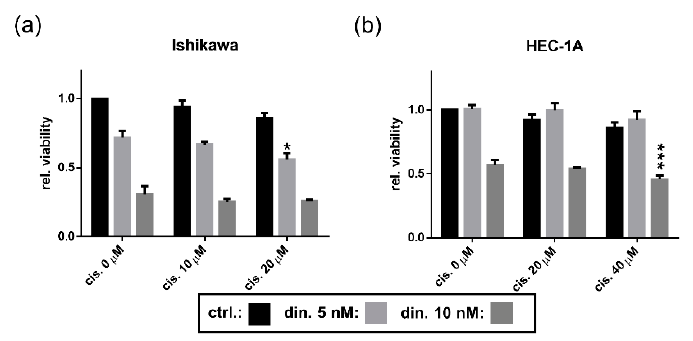
Figure 6. Dinaciclib synergizes with cisplatin in EC cell lines. EC cell lines were treated either individually or in combination with dinaciclib at 5 and 10 nM concentrations and with concentrations of cisplatin reflective of their respective sensitivities (10 and 20 µ M for Ishikawa and 20 and 40 µ M for HEC-1A). Viability was measured and normalized to vehicle controls for ( a ) Ishikawa and ( b ) HEC-1A cells following 48 h of treatment. A combined treatment was considered synergistic where its viability was significantly lower than the viabilities of samples treated with the corresponding doses of each drug individually. Statistical significance was calculated by ANOVA followed by Dunnett’s test. * p value < 0.05, *** p value < 0.001